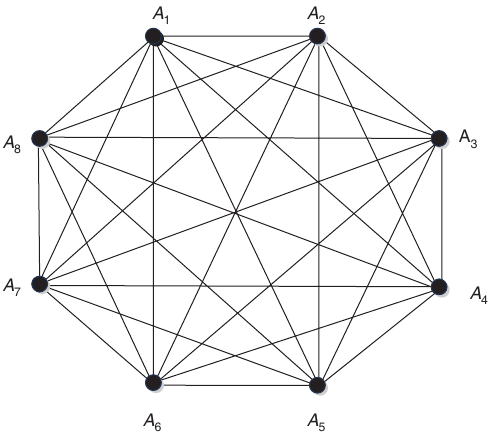
Figure 4. Single-Valued Neutrosophic Graph G ( V , E ) with the Eight